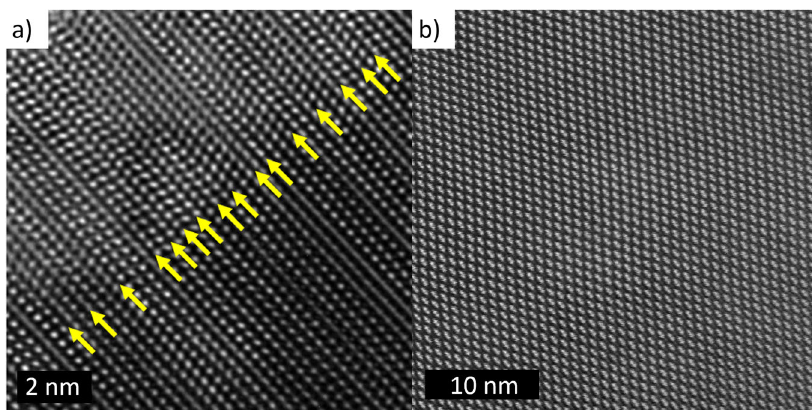
Fig. 3 High-resolution TEM images of CdTe. HRTEM images of CdTe ( a ) before and ( b ) after CdCl 2 treatment showing the existence of a high density of tetrahedral stacking faults (depicted by the yellow arrows) in as-deposited CdTe which are removed during the high-temperature chlorine treatment leaving a purely zinc-blende CdTe structure.